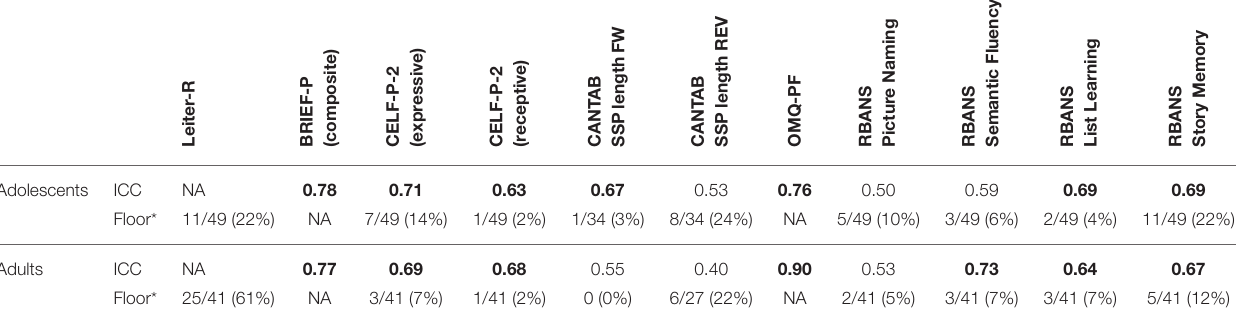
TABLE 3 | Test-retest reliability (ICC) between baseline and 6 months and floor effect at baseline.